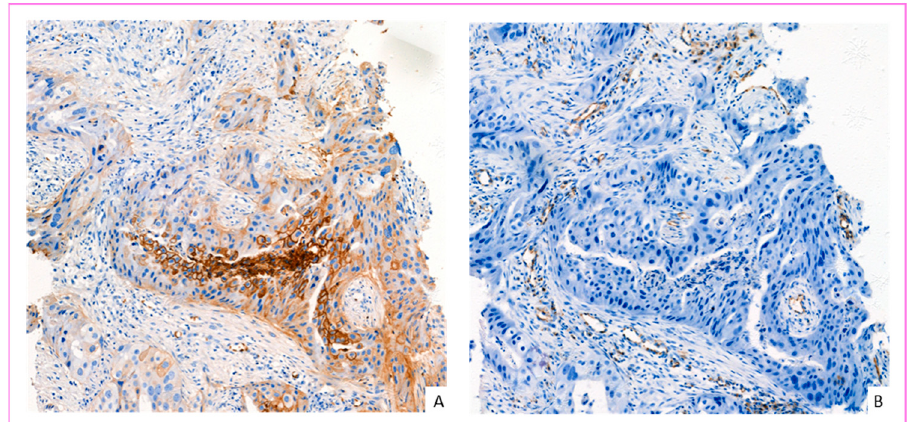
Figure 5. Spatial comparison between GLUT-1 expression and the vascular marker CD31 by im- munohistochemistry on the same breast cancer section. ( A ) High-grade ductal carcinoma in situ with invasive area: this figure shows GLUT-1 expression in carcinoma in situ cells (center), which disappears in the invasive lesion (periphery) ( B ). This image shows the neoangiogenesis and vascu- larization of the tumor stroma by the CD31 endothelial cell marker. The new vessels are located mainly around the invasive carcinoma clusters (magnification ×200).